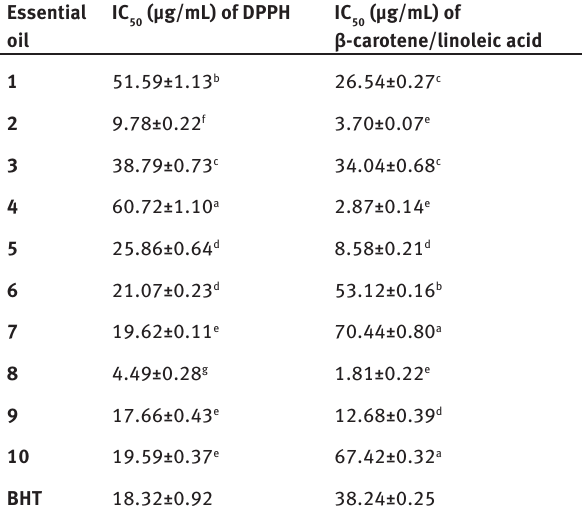
Table 4: The antioxidant activity of essential oils of Hemerocallis cultivars measured in DPPH • and β-carotene/linoleic acid tests. Values are expressed as mean ± SD (n=3). The different letters ( a-g ) in the same column indicate a significant difference between oils (p<0.05). IC (μg/mL) is the concentration of the oil at which 50% is 50